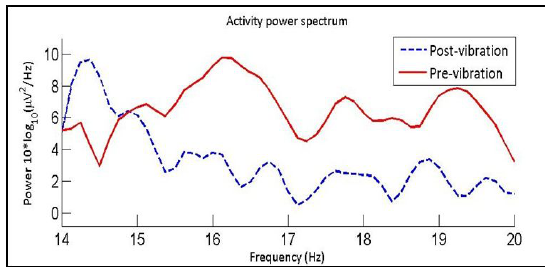
Fig. 8. Figure shows power spectrum density of beta wave before and after vibration. It clearly shows a decrease in power after vibra- tion